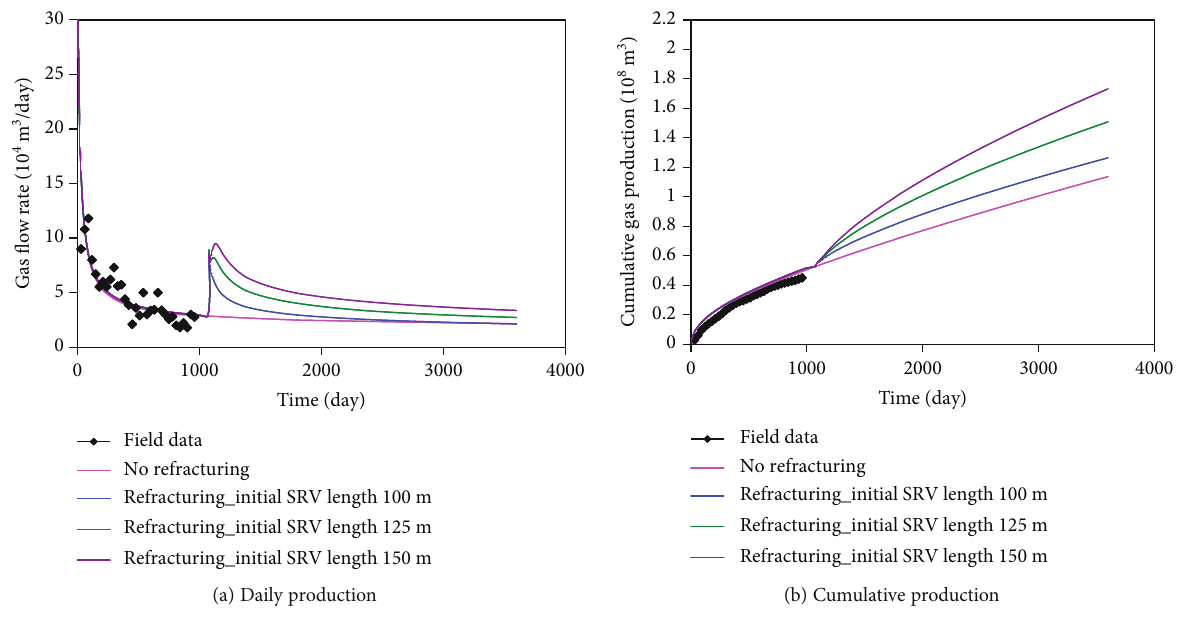
Figure 14: E ff ect of SRV length of refracturing initial fracture on daily and cumulative productions. Table 4: Production increase percentage after 7 years with di ff erent fracture lengths of refracturing initial